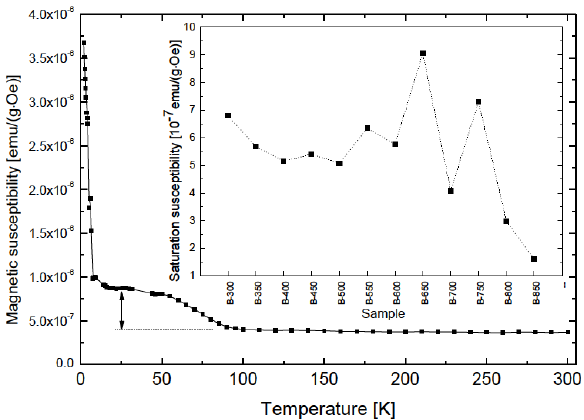
Figure 3: Temperature dependence of χ 2 magnetic susceptibility for B-700 sample in FC mode in magnetic field H = 100 Oe. Vertical arrow defines the saturation susceptibility χ 2 (0) at low tempera- tures of the χ 2 component. Inset shows the values of χ 2 (0) in all investigated